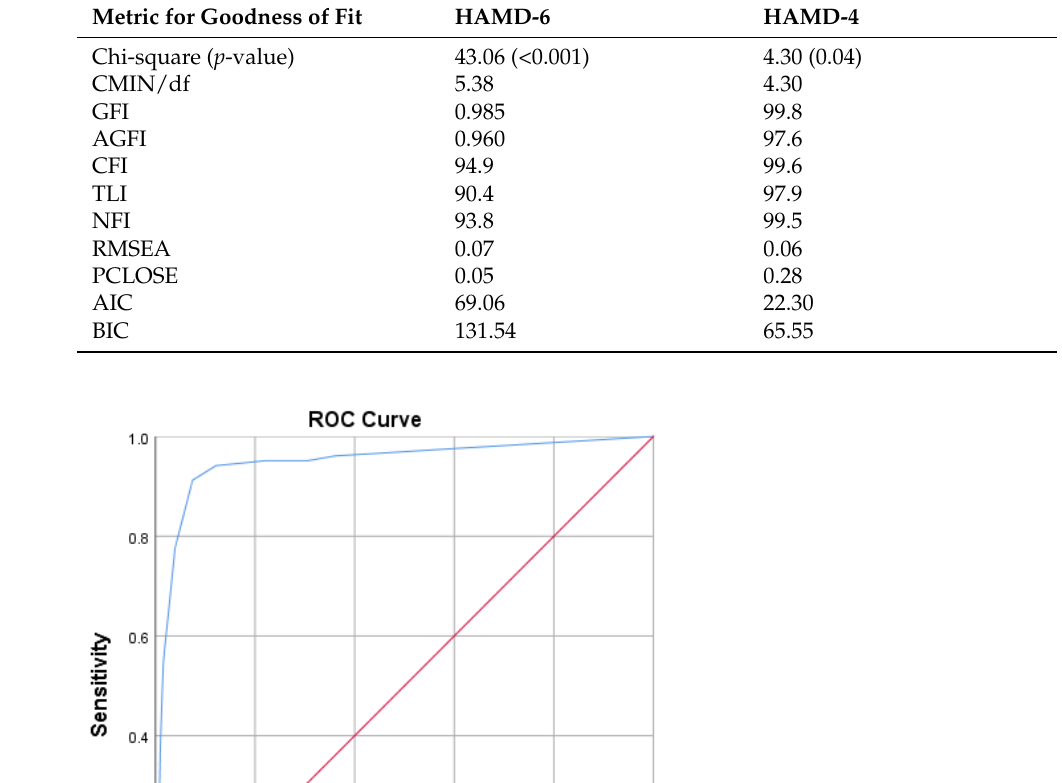
Table 2. Fit indices for the HAMD-6 and HAMD-4.